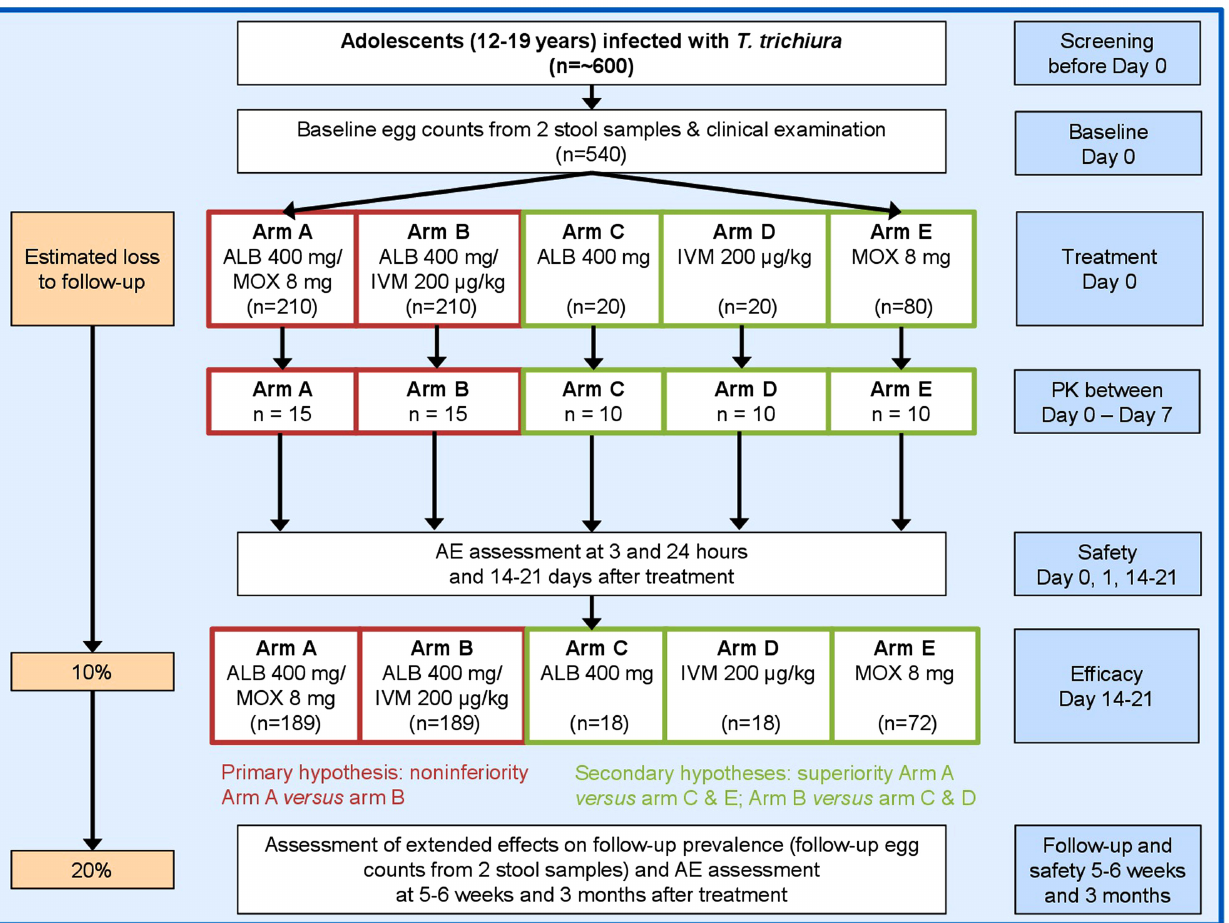
Figure 1. Design and timeline of the randomized controlled trial to be implemented on Pemba Island (Pemba Island, Tanzania). The study is designed as a five-arm trial including two arms with combined treatment through co-administration of separate tablets (arm A ; moxidectin/albendazole, arm B ; ivermectin/albendazole) and three arms with single drug administration (arm C ; albendazole, arm D ; ivermectin, arm E ; moxidectin). Abbreviations: ALB, albendazole; MOX, moxidectin; IVM, ivermectin; PK, pharmacokinetics; AE, adverse